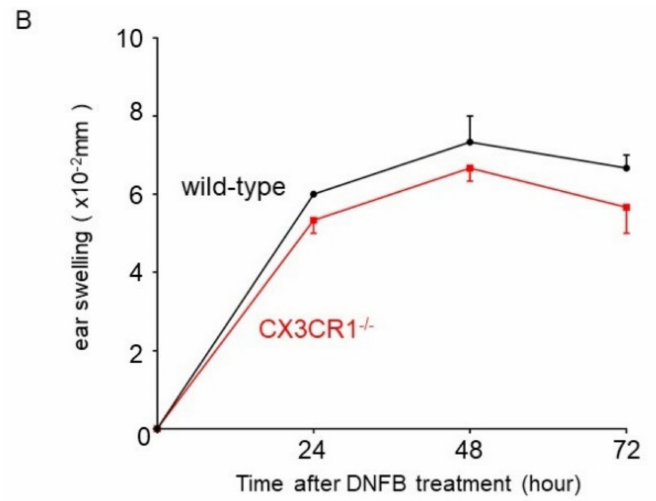
Figure 1. DNFB (2,4-dinitrofluorobenzene)-induced CHS (contact hypersensitivity) is attenuated in CX3CR1 − / − mice. ( A ) Wild-type mice and CX3CR1 − / − mice were sensitized with 0.5% DNFB on days 0 and 1. CHS was elicited by 0.5% DNFB on the right ear on day 6. Ear swelling was measured